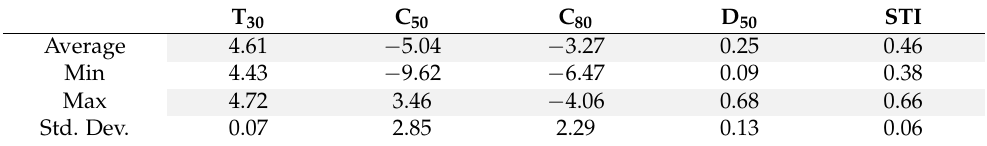
Table 6. The averaged acoustic parameter results at mid-frequencies—source in position